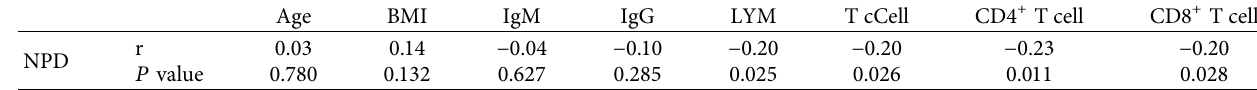
Table 3: Correlations analysis involved antibody and T-cell subtype.